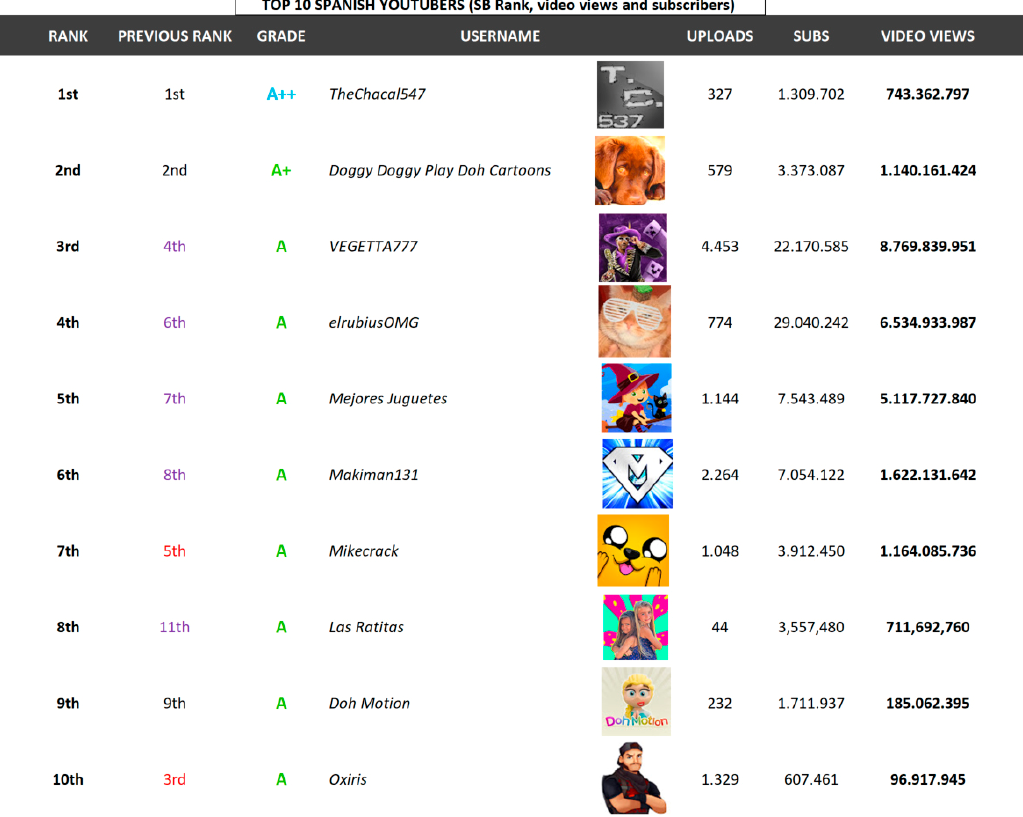
Figure 11. Rank per total number of video views on 5 May 2018 of 10 top Spanish YouTubers in descending order. Source: YouTube.